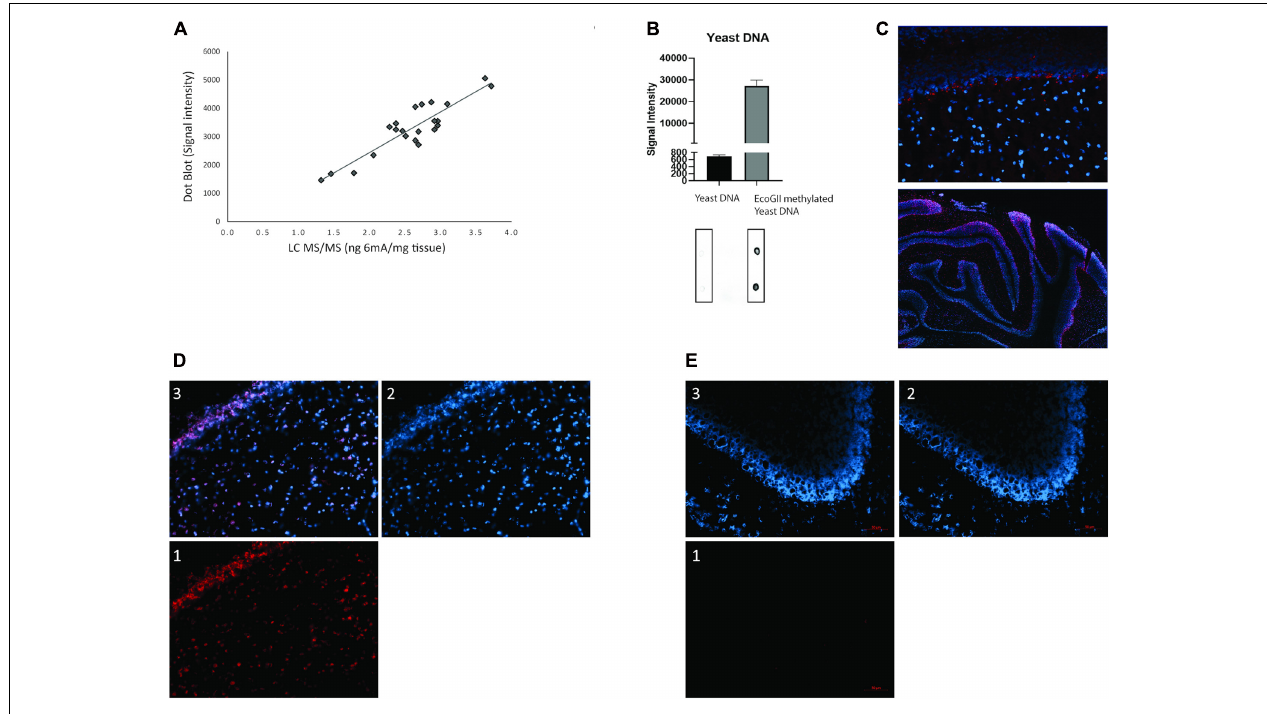
FIGURE 3 | (A) Representation of the linearity between the dot blot and LC-MS/MS techniques (linear relationship was evaluated by Spearman analysis, n = 26, r 2 = 0.81, p < 0.001); (B) Quantification of positive and negative control dot blots with a representative membrane underneath; (C) Immunofluorescence 6mA detection in cerebellum of female and male rats exposed through the dams to α -HBCDD at PND270. DAPI in blue, primary AB anti-6mA in red; (D) Immunofluorescence 6mA detection separated into (1) red channel – 6mA, blue channel – DAPI (2) and merged channels (3); (E) background immunofluorescence separated into (1) red channel – secondary antibody only, blue channel – DAPI (2) and merged channels (3). All images except C upper: 20x objective. C upper: 60x objective. In all images red scale bar 50 µ